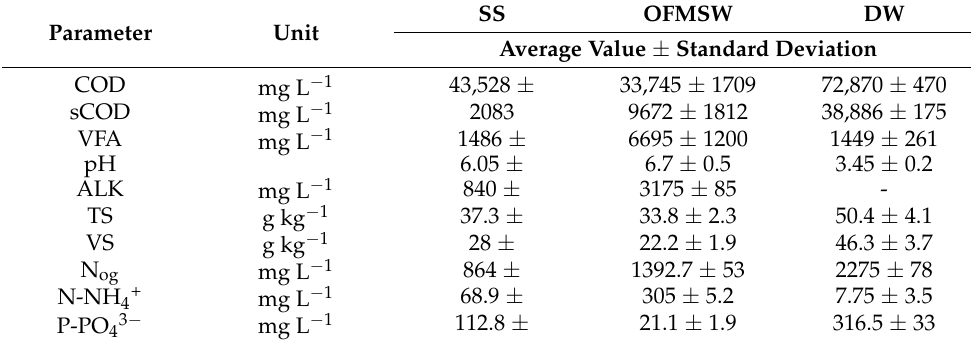
Table 1. Composition of substrates used in experiments.